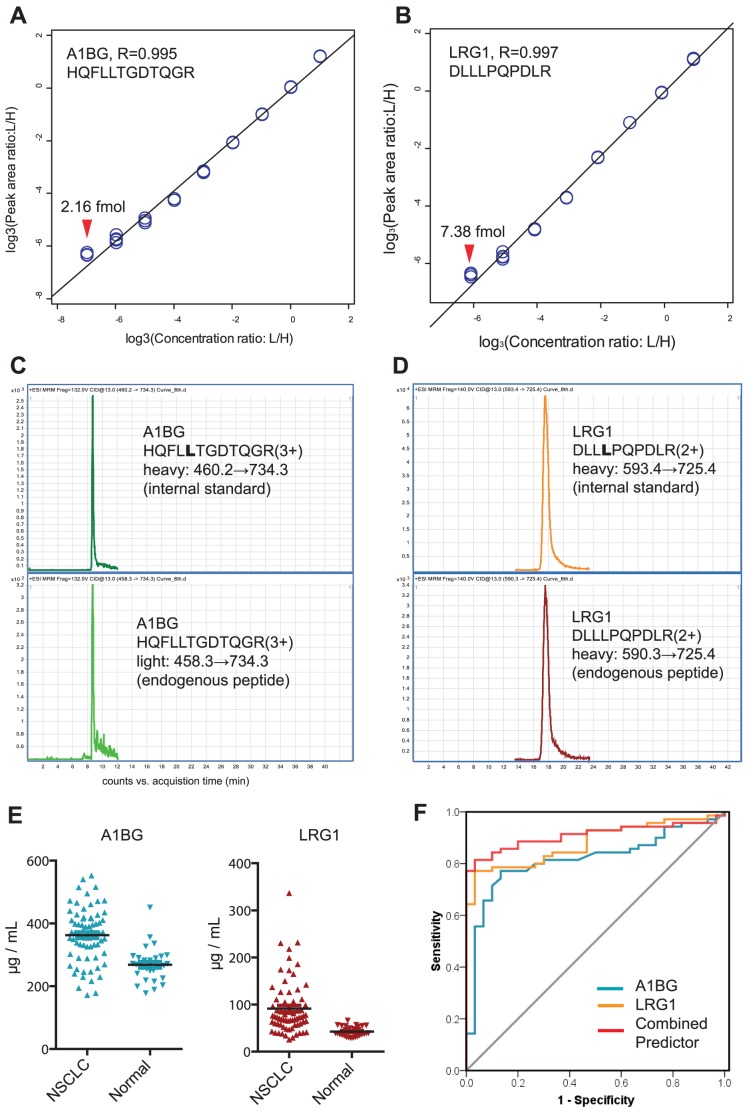
The MRM measurement of serum concentrations of A1BG, LRG1 and their association with NSCLC.(A–B) MRM Intensities of selected reference peptides of A1BG and LRG1 both showed good linear correlation with on-column abundance. The x-axis represents base-3 logarithm of ratios of spiked light and heavy isotopic peptides, with the y-axis corresponding to the observed peak area ratios in base-3 logarithmic scale. Red triangles suggest the limit of linear quantification (LOQ) of each peptide. Note that these two peptides were used to report the absolute concentration, with comparison to another two less-optimal peptides shown in Figure S4. (C–D) The chromatography peaks of the best transitions of two peptides for A1BG and LRG1. Note that the Signal-to-Noise ratios are sufficient for quantification. (E) The distribution of serum levels of A1BG and LRG1 between cancer and control groups. (F) ROC analysis suggested over-expressed A1BG and LRG1 were associated with NSCLC and their combined panel could provide the better discriminative performance than each of the protein.